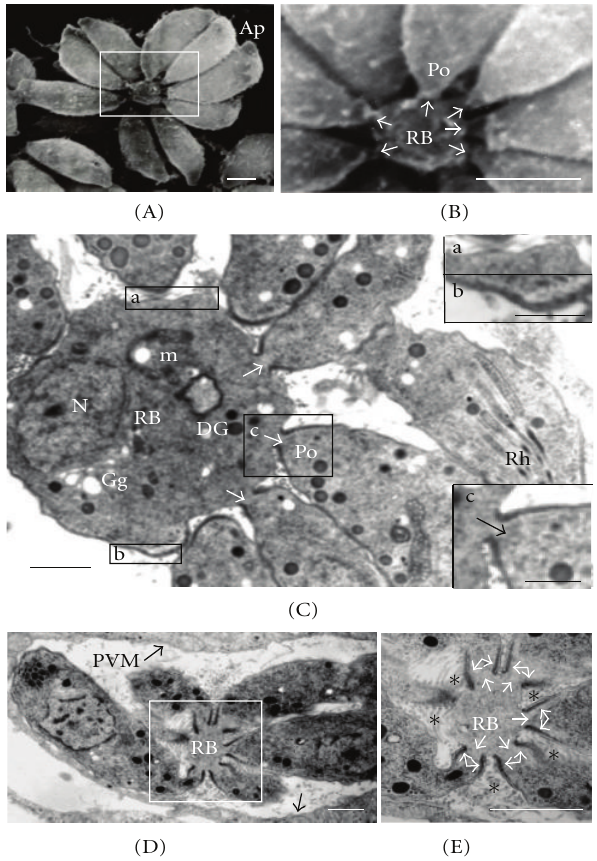
Figure 2: The residual body is a structure derived from a mother cell that contributes to the intravacuolar organization of parasites in rosettes. (A) Intravacuolar “rosette” micrographed after SEM- Tanaka processing. (B) Magnification of the area squared in (A) showing a link between the RB and the posterior ends of the proliferating tachyzoites (arrows). (C–E) micrographs obtained by thin sectioning. Arrows in (C–E) indicate membrane fusion be- tween the RB limiting membrane and the tachyzoites membrane at the posterior end and the continuity between tachyzoites and the RB cytoplasm. (E) High magnification of the area squared in (D). Asterisks in (E) indicate accumulation of MNN at the periphery of the RB, and double arrows indicate parasites’ posterior polar ring. Insets in (C) represent the di ff erent types of membranes that limit the RB: a unit membrane (a) or a pellicle-like composed of three layers (b). Inset (c) in (C) indicates membrane fusion between the RB and the posterior end of a parasite. Ap: apical end of the tachyzoite; DG: dense granule; Gg: Golgi; m: mitochondria; N: nucleus; PVM: parasitophorous vacuole membrane; Po: posterior end of the tachyzoite; RB: residual body; Rh: rhoptries. Bars = 1 µ m; Bars in insets b and c =